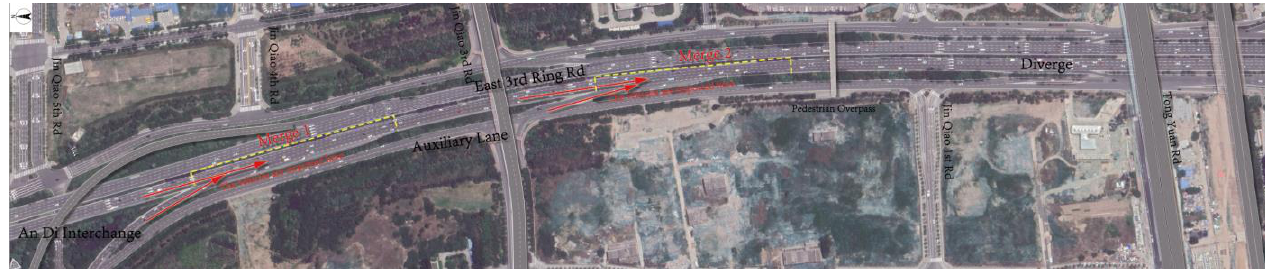
Figure 7. Survey site and objects.